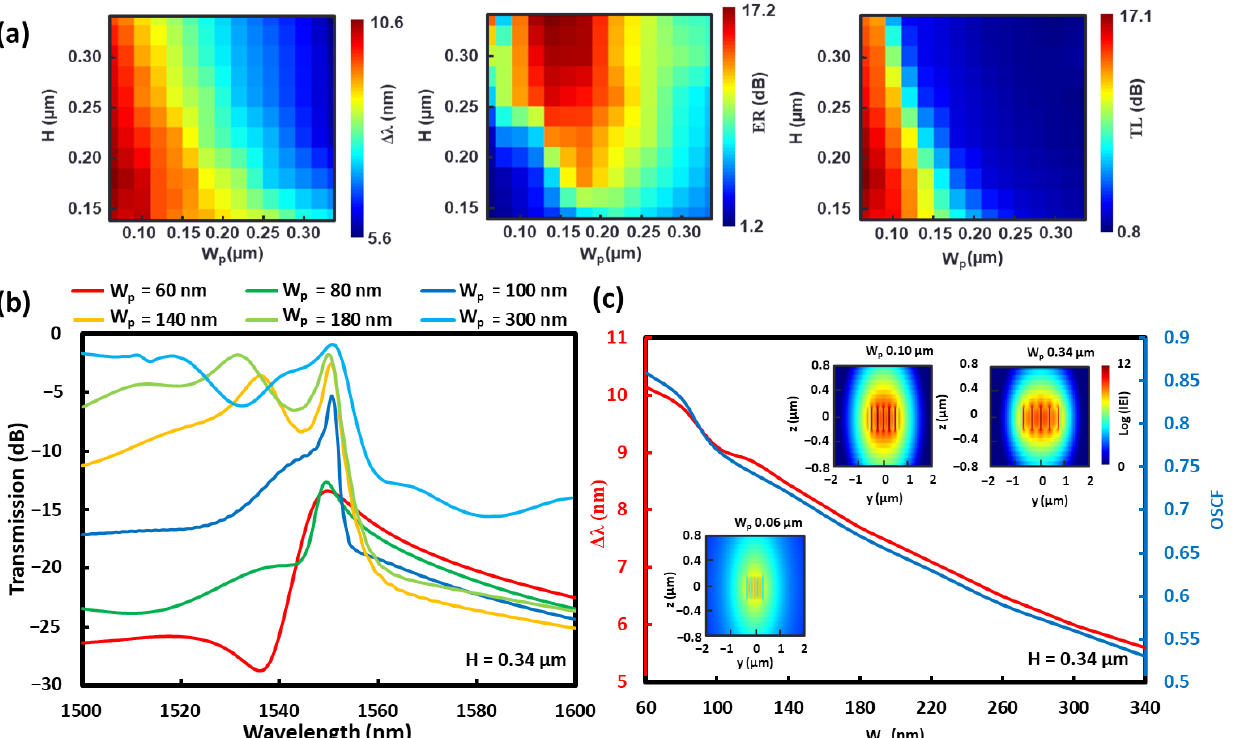
Figure 7. ( a ) Mapping of characteristics of CSAW BG RI sensor, Δλ, ER and TL, dependent on H and W p with other parameters as W s = W su = 60 nm, W w = d = c = 100 nm, and N = 20. ( b ) Simulated transmission spectra for various W p values with H = 340 nm and ( c ) simulated OSCF and dependent on W p . Insets show electric field profiles in logarithmic scale at 10th pillar area cross-sections.